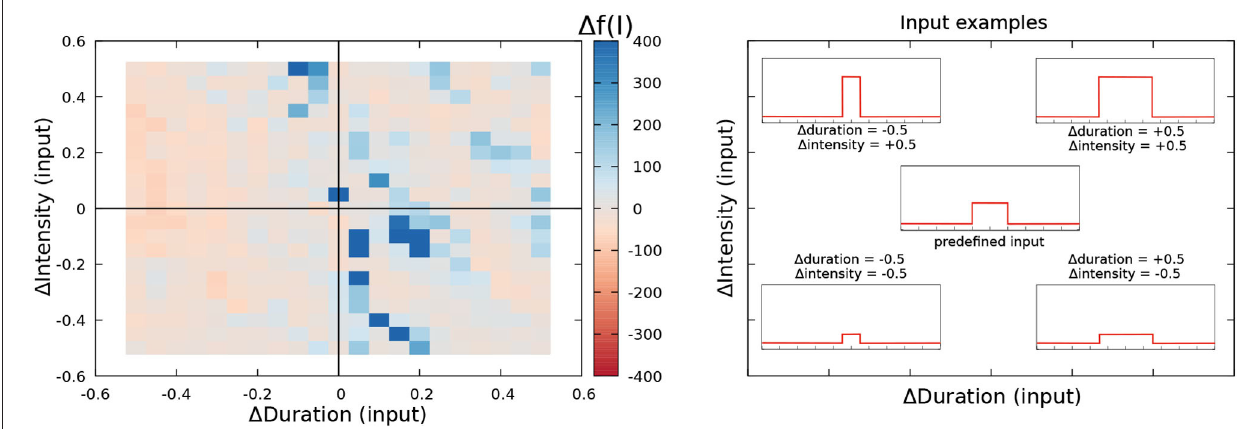
FIGURE 5 | Robustness to input variability analysis of the R-GA electromotor model tuned to recorded G. petersii SPI patterns (Left). The central point in the left panel represents the reference fitness value. The one obtained simulating the model under the predetermined simulation conditions (i.e., 1 Duration = 0 and 1 Intensity = 0). Duration and intensity of the step function current input were varied from –0.5 to 0.5 from their initial values, and the relative change in the fitness value was calculated as described by Equation 9. Reddish colors represent decreases in the fitness value under variable stimulation. White colors represent an equivalent result to the reference fitness value. Blueish colors represent an improvement in the fitness value. Representative example of distinct current inputs in the simulation at different places of the chart